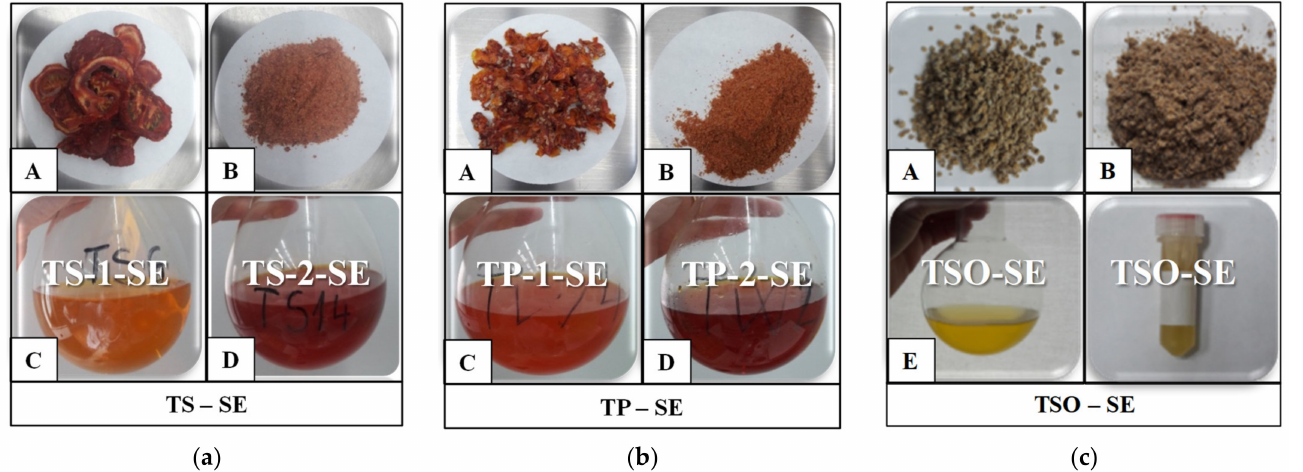
Figure 2. Tomato samples and raw extracts obtained with Soxhlet extraction (SE) using extraction solvents (1) bioethanol and (2) ethyl acetate, A—samples before grinding, B—samples after grinding, C—bioethanol extract (1), D—ethyl acetate extract (2), E—hexane extract before and after evaporation of the solvent: ( a ) tomato slices (TS); ( b ) tomato pomace (TP); ( c ) tomato seeds